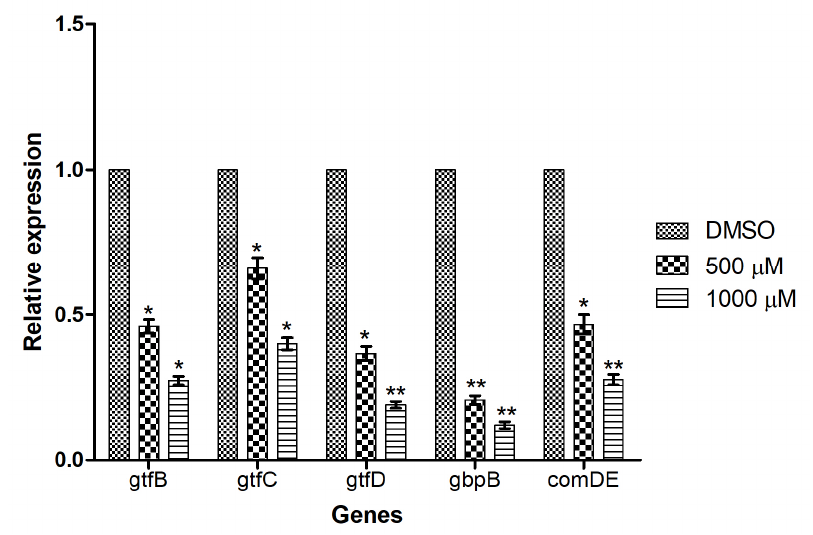
Figure 6. Effect of mangiferin on expression of genes involved in S. mutans biofilm formation. Data means ± standard deviations (SD (n = 3). * p < 0.05, ** p < 0.01, represents significantly statistical difference from the control group.